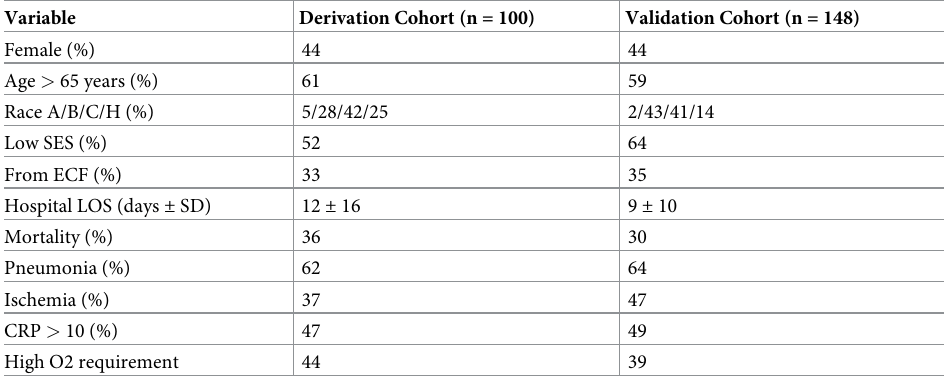
Table 1. Patient